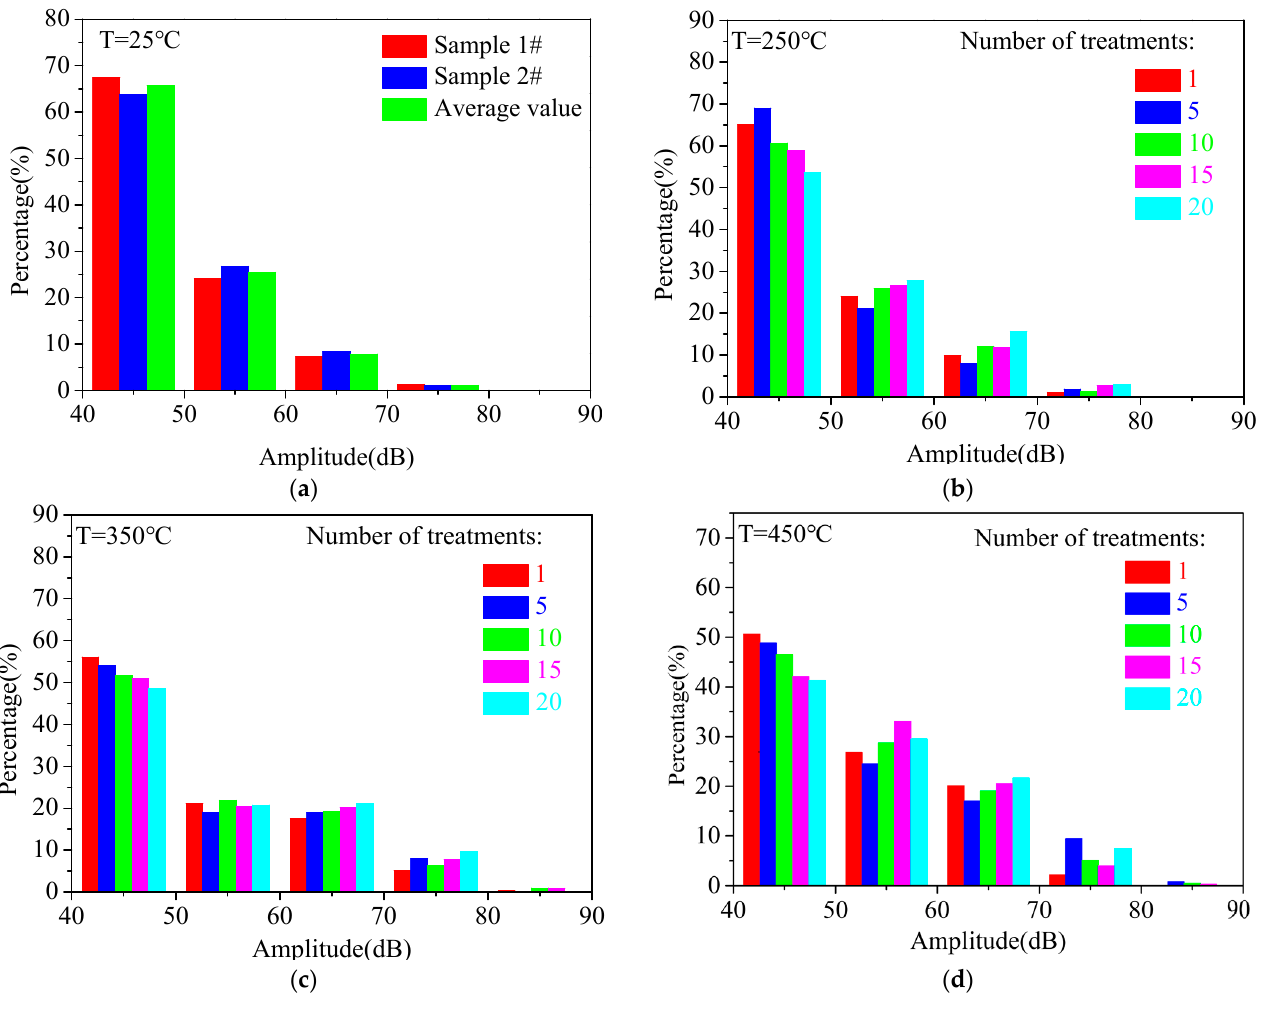
Figure 8. Frequency distribution of maximum amplitude values of acoustic emission of specimens during uniaxial compression. ( a ) T = 20 °C. ( b ) T = 250 °C. ( c ) T = 350 °C. ( d ) T = 450 °C.